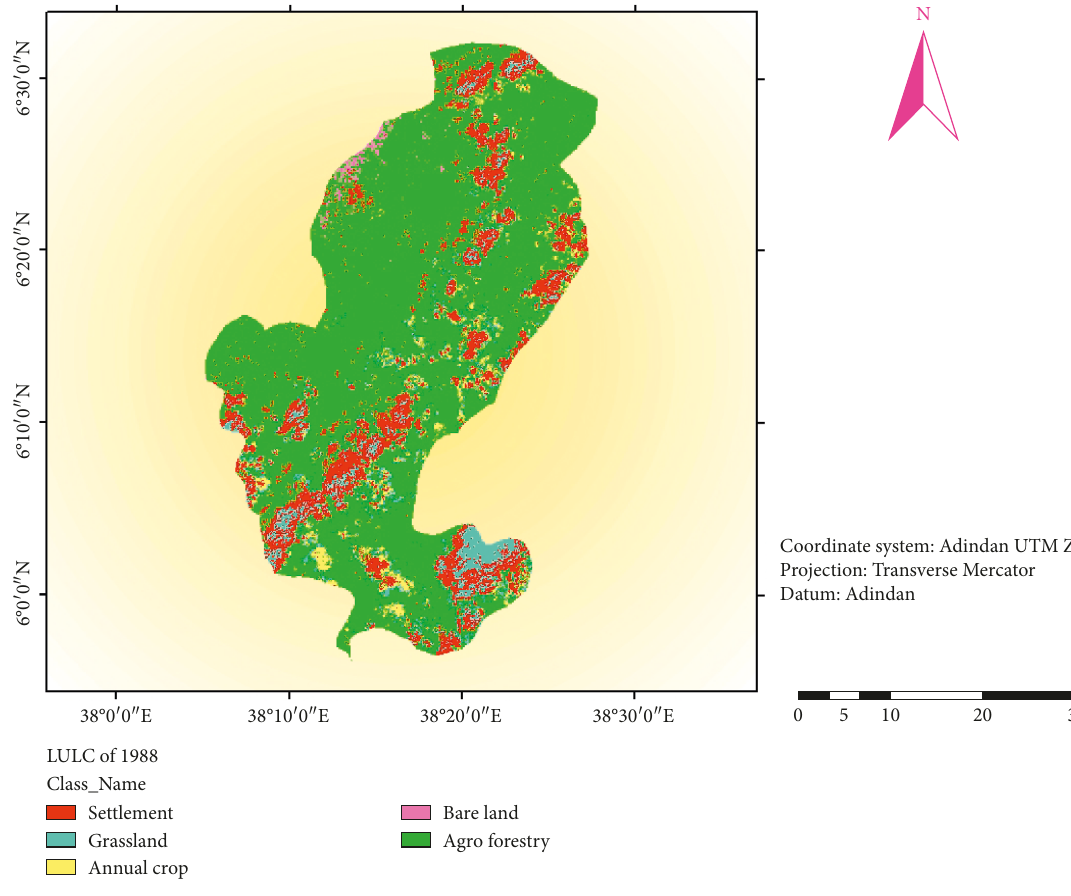
Figure 9: Land use land cover of map of